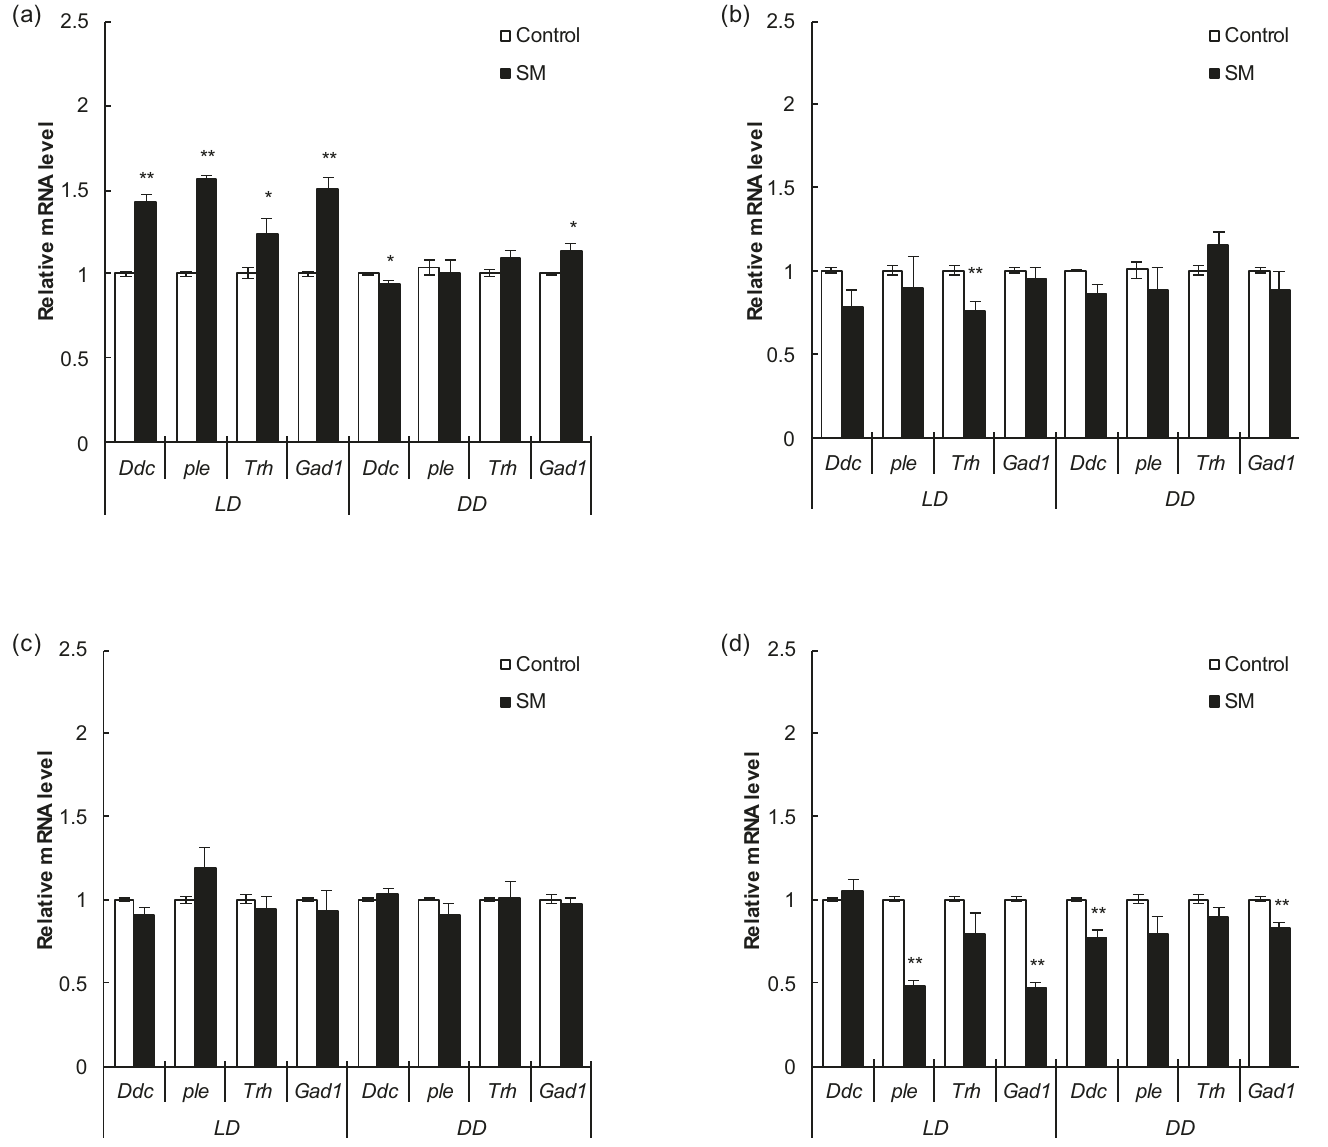
Fig. 5 Relative expression levels of target neurotransmitter-related genes after 3 days of simulated microgravity under LD and DD conditions. a Canton-S males. b Canton-S females. c w1118 males. d w1118 females. White and black boxes represent data for the control and simulated microgravity fruit fl ies, respectively. * P < 0.05, ** P < 0.01. Error bars represent standard